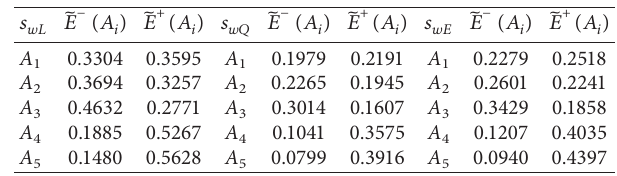
Table 3: Similarity measure between each alternative A A − and BPPIS A + .